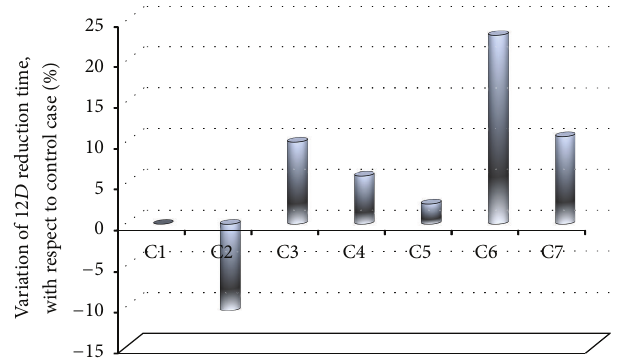
Figure 6: Variation of time required to attain a 12𝐷 reduction of target microorganism with respect to the control case, C1. C1: 𝑈 = 0 Wm −2 K −1 , control case; C2: 𝑈 = 0 Wm −2 K −1 and electrical conductivity +10% with respect to S1; C3: 𝑈 = 0 Wm −2 K −1 and electrical conductivity − 10% with respect to S1; C4: 𝑈=5 Wm −2 K −1 , with electrical conductivity as in S1 and 𝑇 inf = 286.15 K; C5: 𝑈 = 5 Wm −2 K −1 , with electrical conductivity as in S1 and 𝑇 C6: 𝑈 = 15 Wm −2 K −1 , with electrical conductivity as in S1 and = 286.15 K; C7: 𝑈 = 15 Wm −2 K −1 , with electrical conductivity 𝑇 inf as in S1 and 𝑇 inf = 314